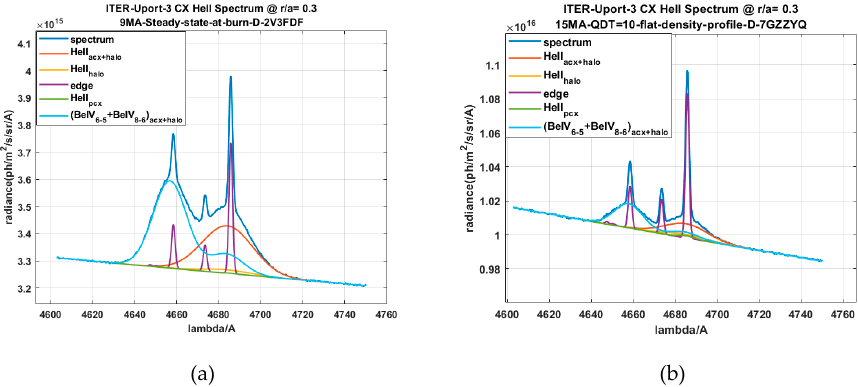
Figure 13. ( a ) SOS halo-model spectrum for HeII/BeIV CX Spectra. The synthetic line-of-sight-